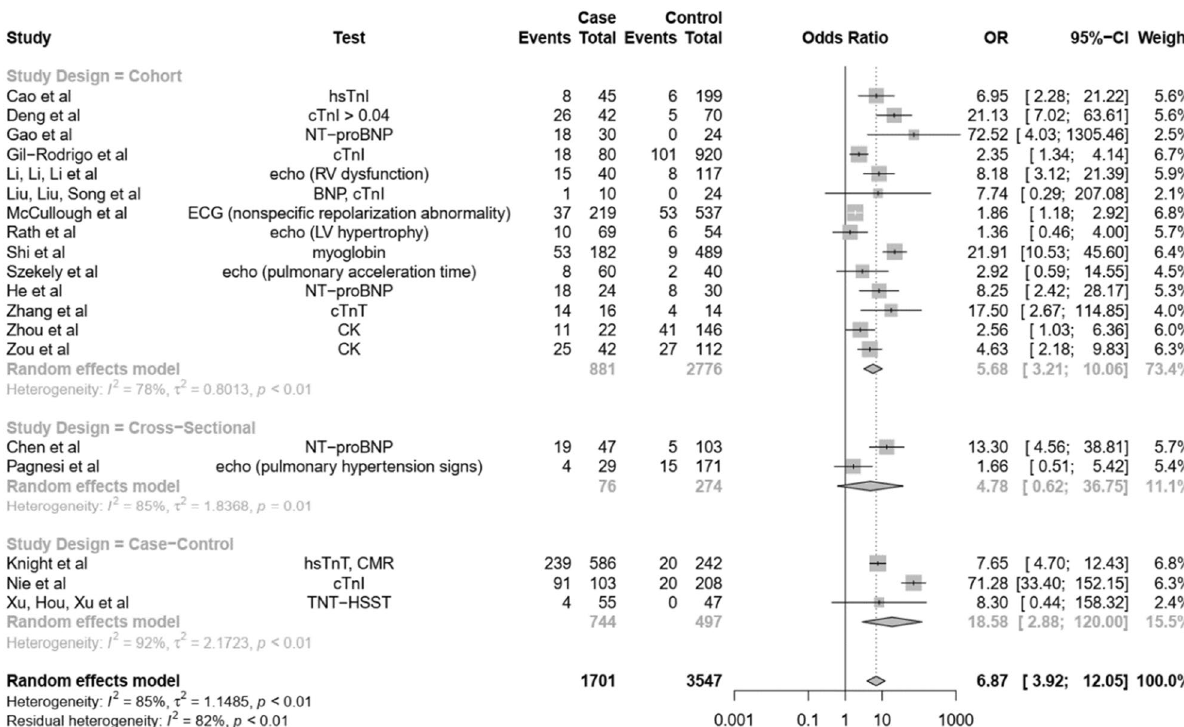
Figure 2. Forest plot showing the pooled prevalence of cardiac abnormalities in patients with COVID-19.